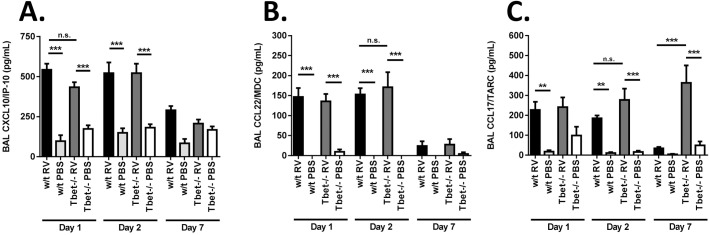
Airway chemokine expression in RV infected Tbet deficient and wild type mice.Wild type and Tbet-/- mice were infected intranasally with RV1B or sham infected with PBS. On days 1, 2 and 7 post-infection lungs were lavaged and chemokines CXCL10/IP-10 (A), CCL22/MDC (B) and CCL17/TARC (C) in lavage supernatants were measured by ELISA. n = 7–8 mice/group. ***p<0.001, **p<0.01, *p<0.05, n.s. not significant.